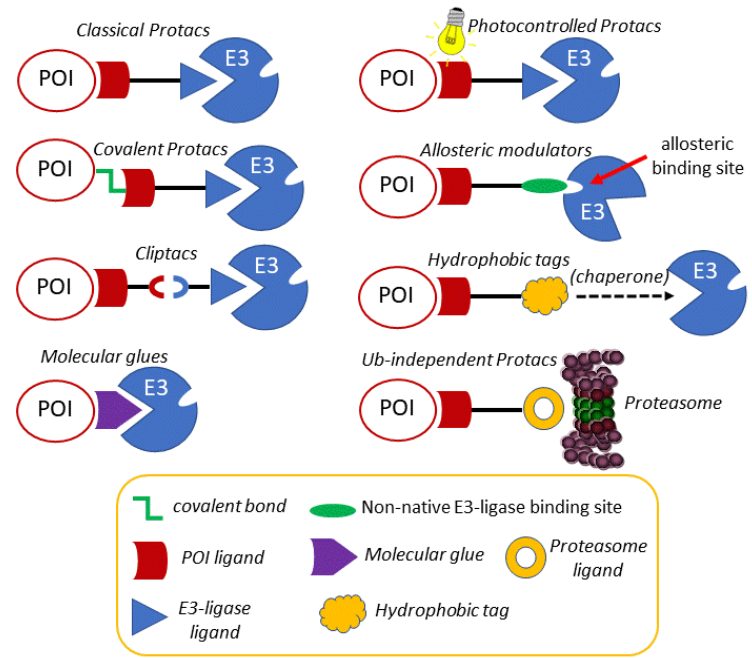
Figure 3. Conceptual representation of the different proteolytic chimeras described in Section 3.